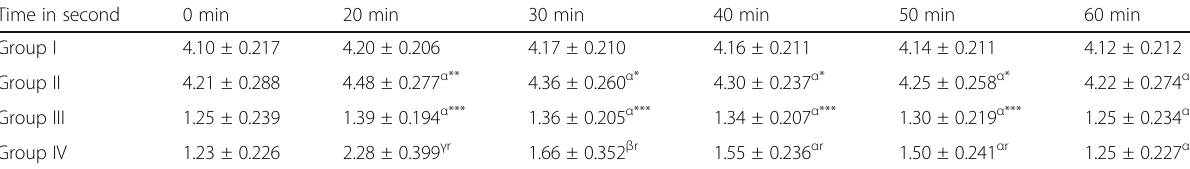
Table 3 The effect of single dose of Momordica charantia on Serum insulin level in normal and diabetic Wistar